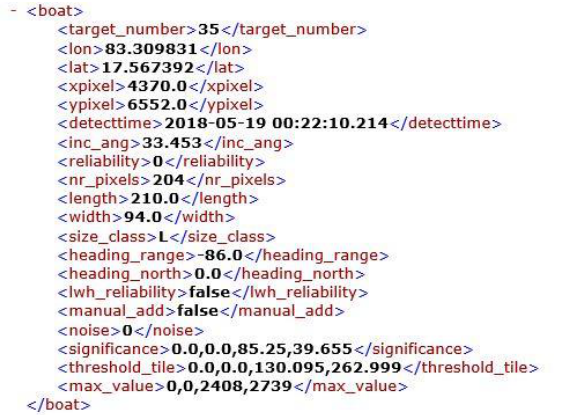
Fig.6 Output result of a ship’s attributes in XML format